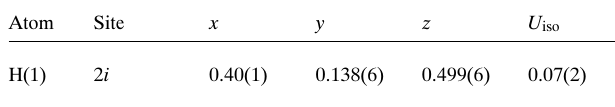
Table 2. Atomic coordinates and displacement parameters (in Å 2 )